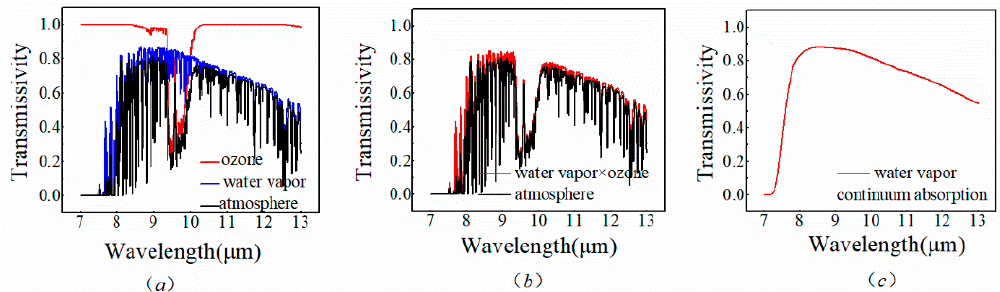
Figure 4. Mid-Latitude Summer transmittance curve: ( a ) Atmospheric transmittance curve and transmittance curve of main absorption components ozone and water vapor; ( b ) Atmospheric transmittance curve and product curve of ozone transmittance and water vapor transmittance; ( c ) Water vapor continuum absorption transmittance.